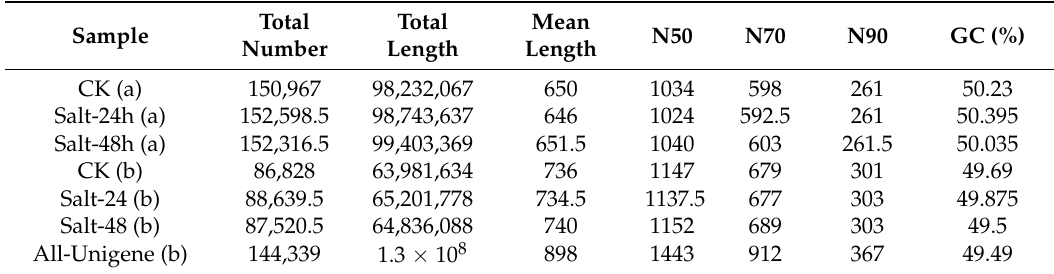
Figure 1. Graphical representation of unigenes based on ( a ) Venn diagram depicting the overlap in various databases. The number outside the circle denotes the total number of unigenes in each database. The number within one circle denotes the overlapped unigenes, respectively. ( b ) Species distribution showing the proportions of different species associated with the unigene annotations according to the results of the NR annotations. Table 2. ( a ) Trinity statistics. ( b ) Unigenes